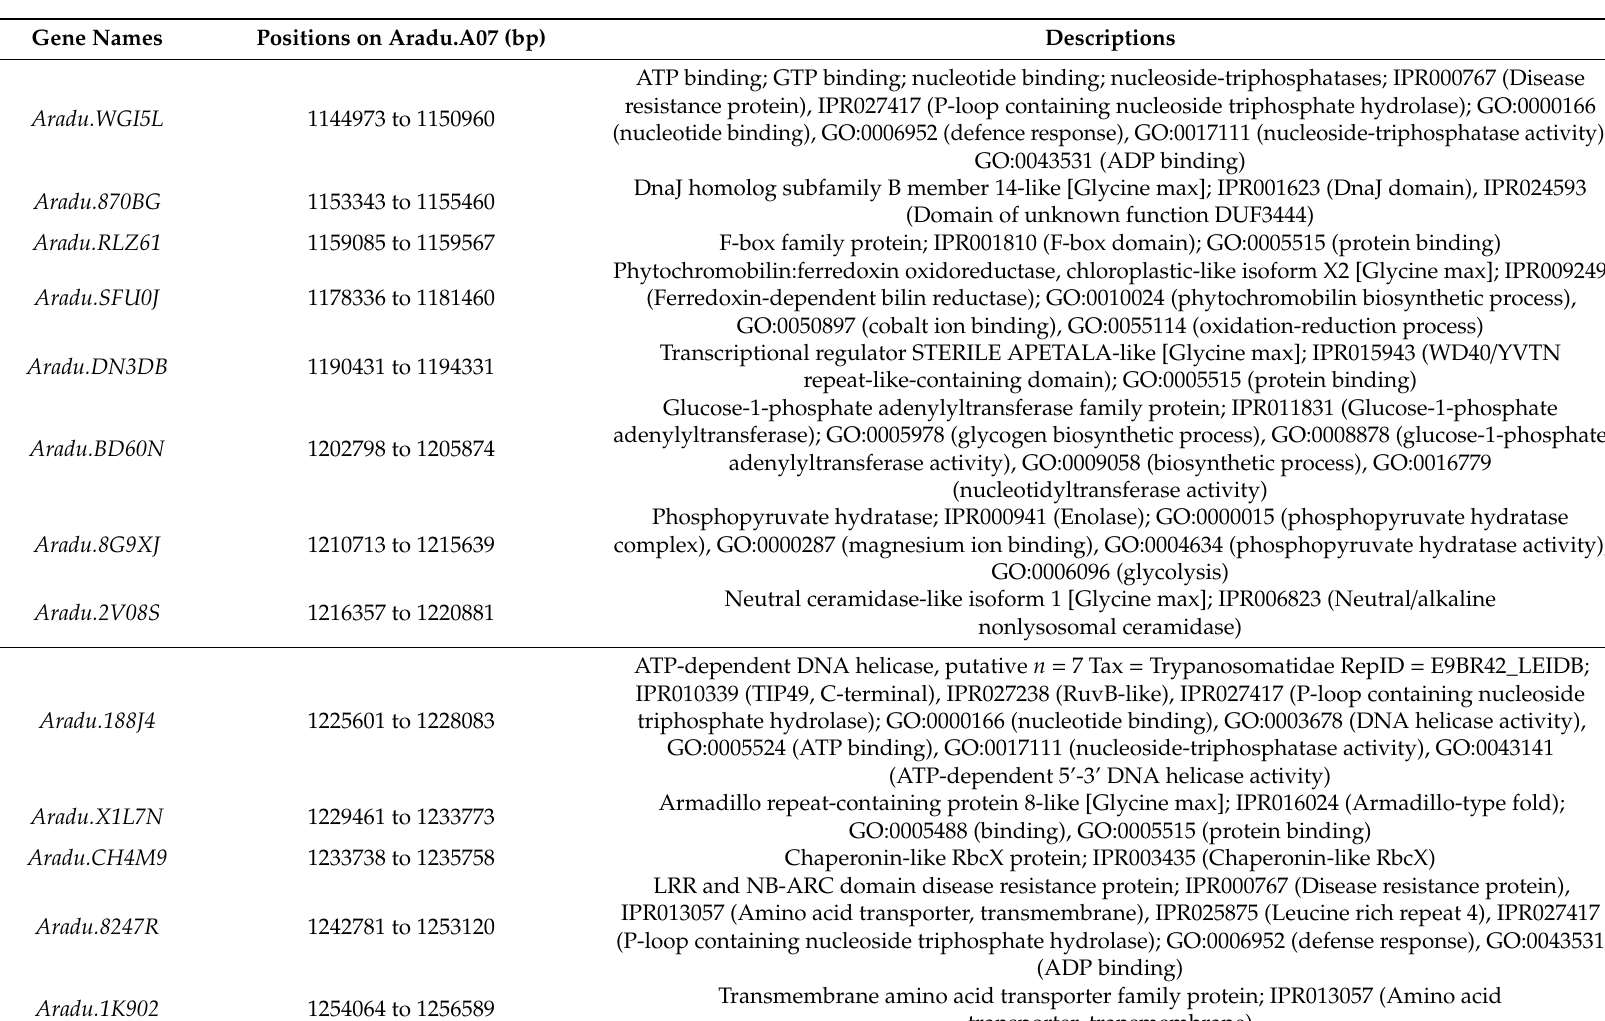
Table 3. Candidate genes found in the identified